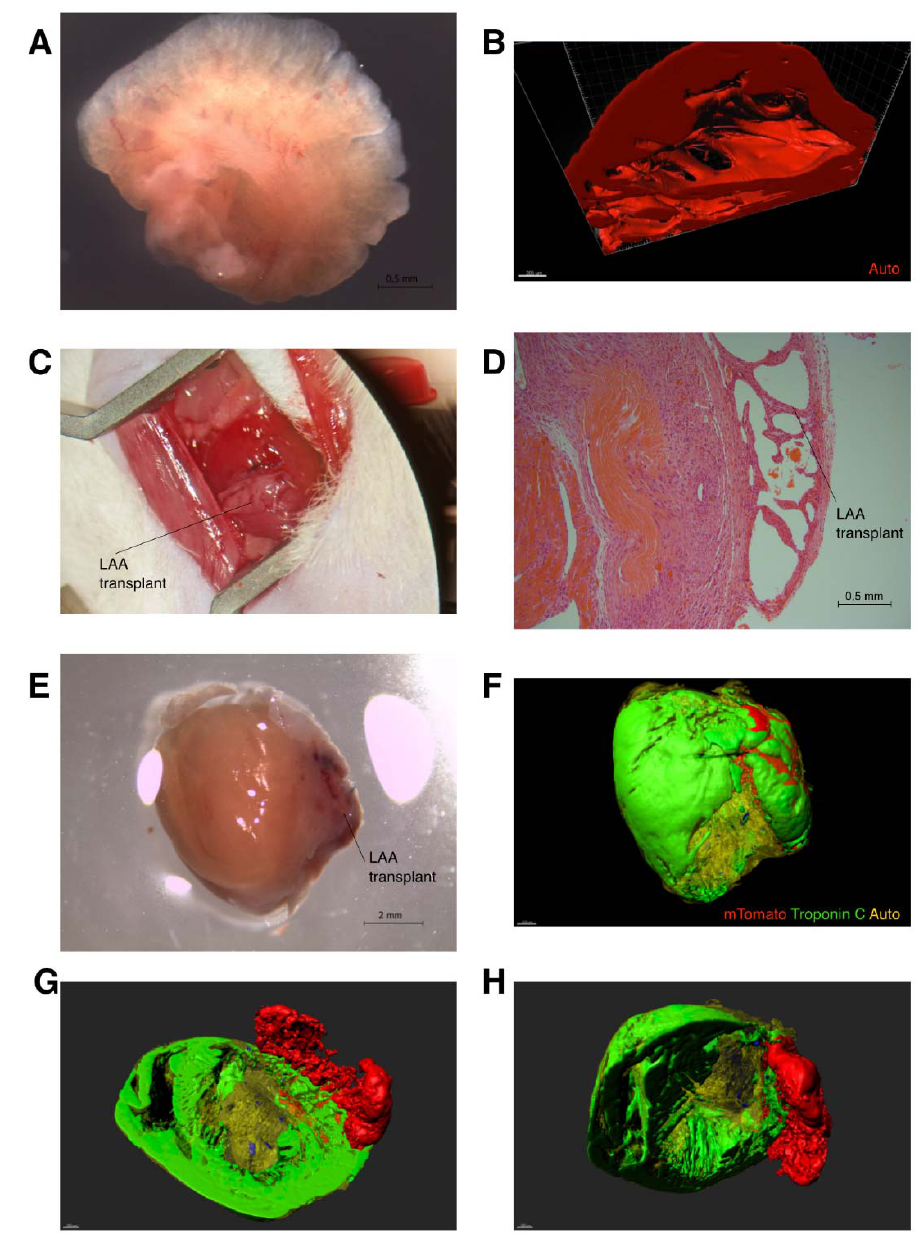
Figure 1. Left atrial appendage transplantation operation and 3D visualization of the transplant. ( A ) Visualization of a detached LAA before transplantation. ( B ) 3D image of the attached LAA using autofluorescence. ( C ) Visualization of the LAA attached to the border ‐ zone of myocardial infarction. ( D ) H&E staining 2 weeks after operation showing LAA attached to the ventricular wall; the fibrotic scar is also seen. ( E ) LAA transplant (mTomato) with MI 2 weeks after operation. ( F – H ) Whole mount images of the same specimen using the iDisco clearing and immunostaining protocol. (mTomato = red, mTomato (migrated cells) = blue, troponin C = green, and autofluorescence = yellow).